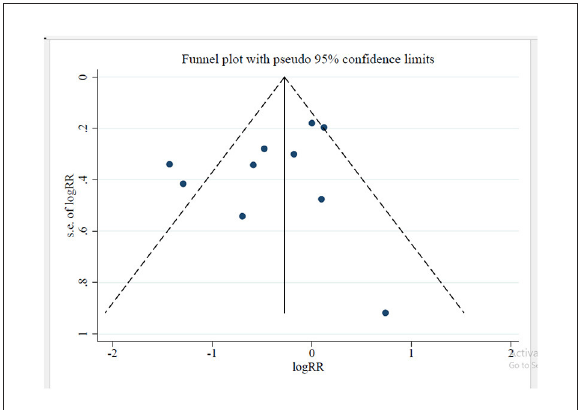
FIGURE4 Funnel plot for GDM showing no publication bias.